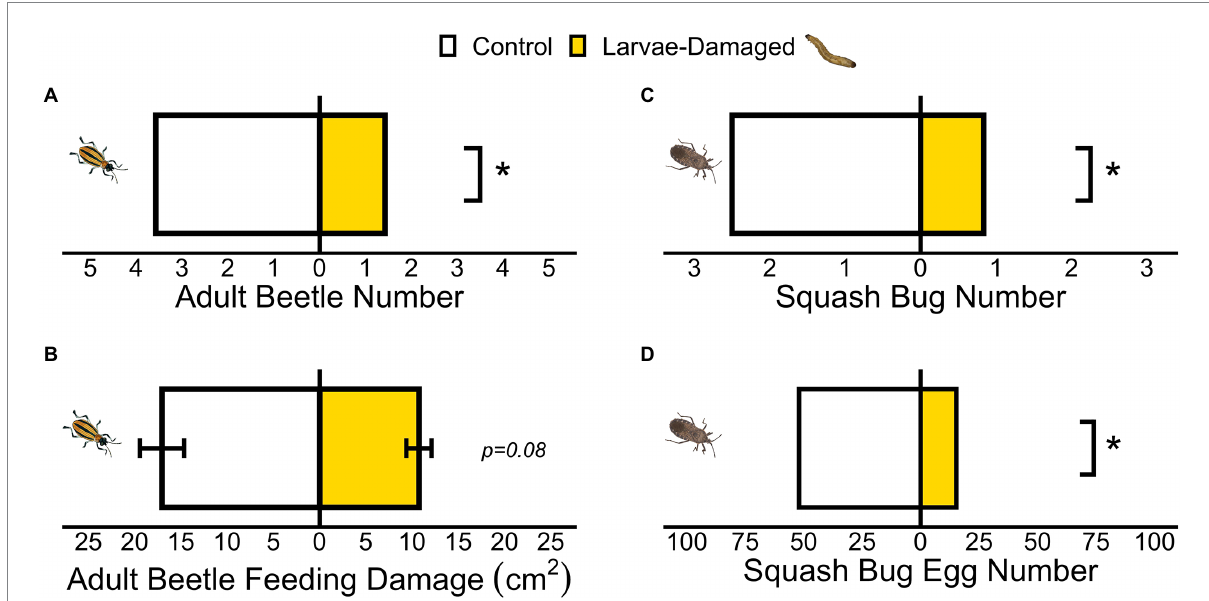
FIGURE 2 (A) Belowground larval herbivory deterred aboveground foraging adult beetles. (B) Adult beetles fed similarly when presented the choice between control and larvae-damaged plants. Squash bugs avoided (C) settling on and (D) laying eggs on belowground larvae-damaged plants. (* p ≤ 0.05) Means ± SE are